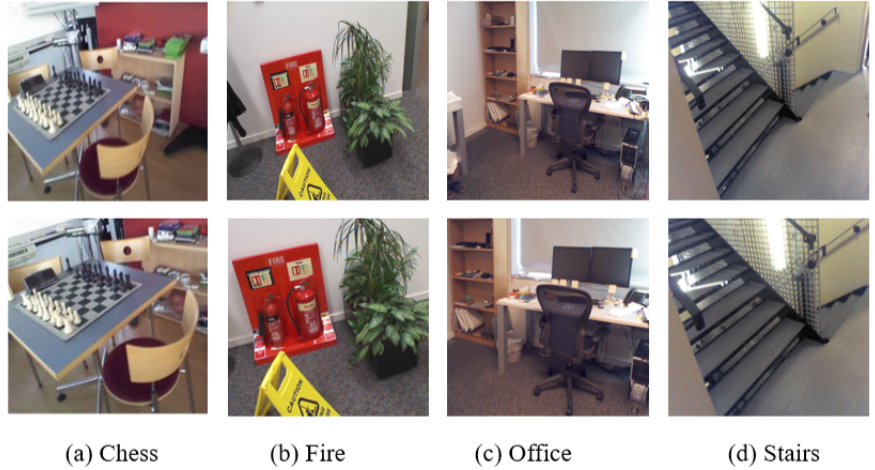
Figure 9. The testing images (above) obtained by center cropping and zooming; selected images (below) obtained by DLISS. The positional error and angular error of these images are as follows: ( a ) above: 0.283 m, 3.965 ◦ below: 0.275 m, 3.951 ◦ ; ( b ) above: 0.384 m, 12.318 ◦ below: 0.366 m, 9.261 ◦ ; ( c ) above: 0.403 m, 6.732 ◦ below: 0.371 m, 6.511 ◦ ; ( d ) above: 0.311 m, 7.874 ◦ below: 0.296 m, 7.276 ◦ . We prove that DLISS can reduce the positional error and angular error in testing